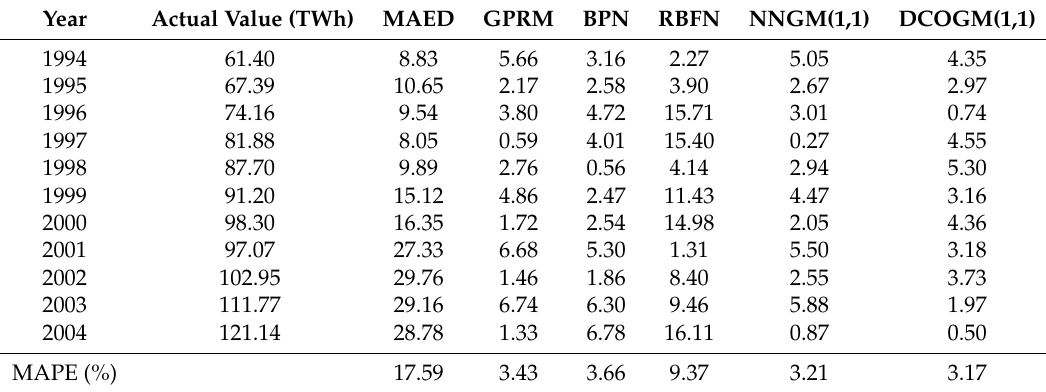
Table 2. APE and MAPE obtained by different methods for total electricity consumption.